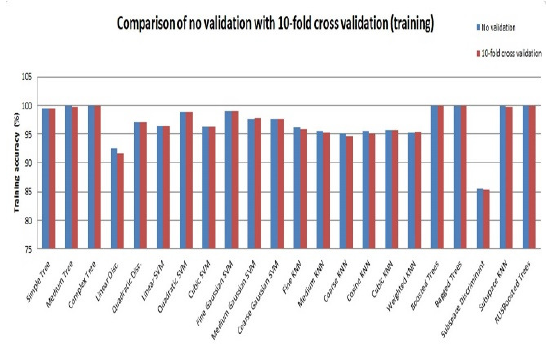
Fig. 7: Comparison of training accuracies (no validation vs. 10-fold cross